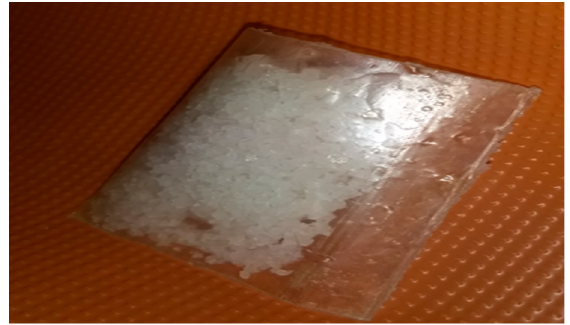
Figure 5. Sealed bioplastic bag.